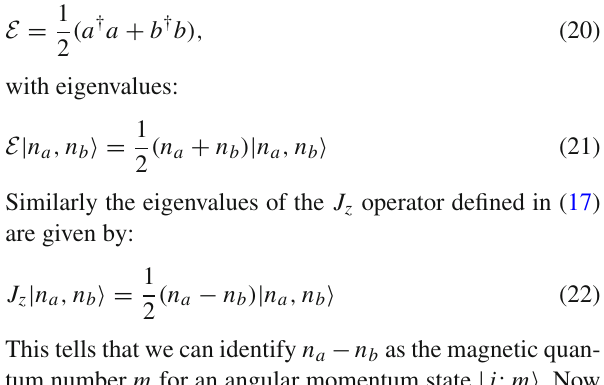
Fig. 4 An example of a spin-network vertex, with the associated poly- hedron. The faces of the polyhedron are transverse to the edges attached to the vertex. The vertex itself lies in the interior of the polyhedron. Each edge punctures one of the faces and assigns it a quantum of area depending on the spin rep labelling the edge